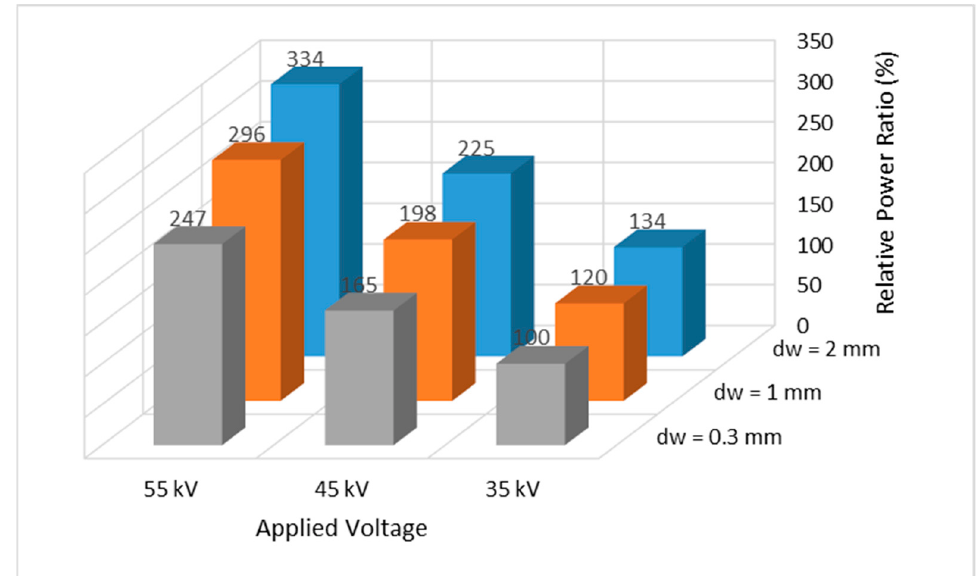
Figure 18. Relative power consumption comparisons based on the corona wire diameter and the applied